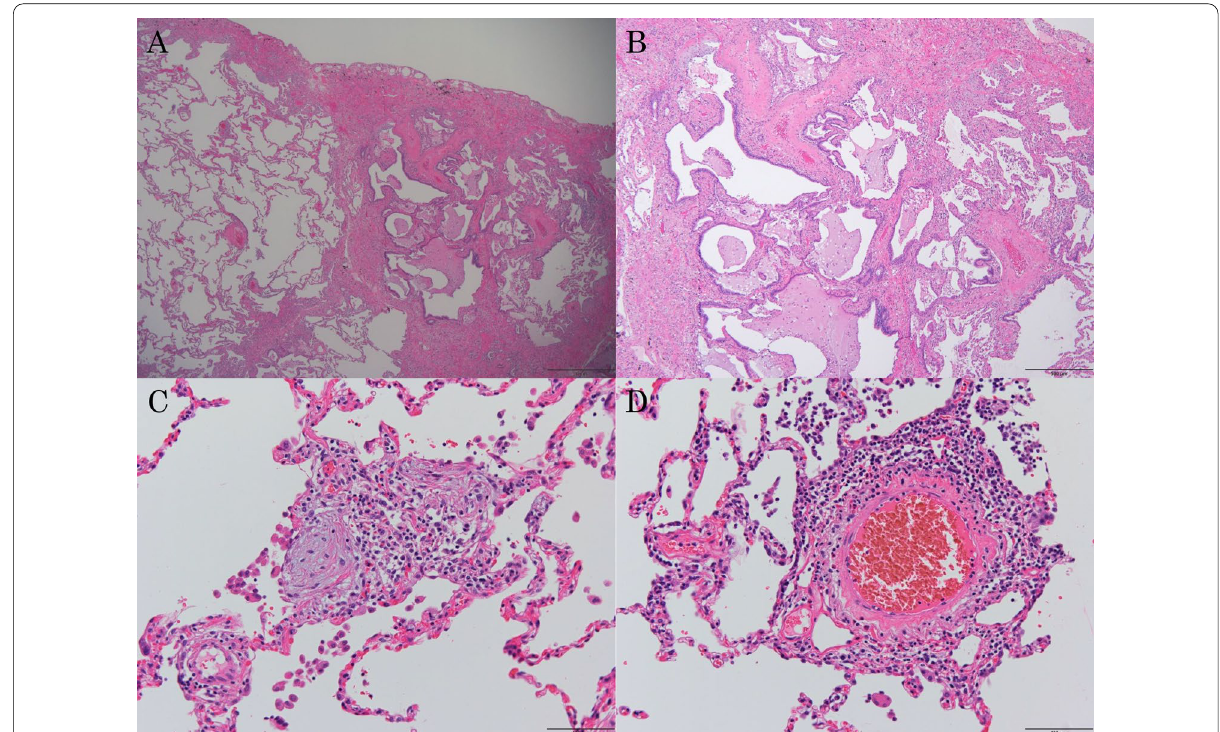
Fig. 2 Pathological examination of the resected specimen showing usual interstitial pneumonia in the non-cancerous areas of the lung ( A , B ). Infiltration of immature fibroblasts is visible in the alveoli ( C ), and perivascular infiltration of inflammatory cells was observed ( D